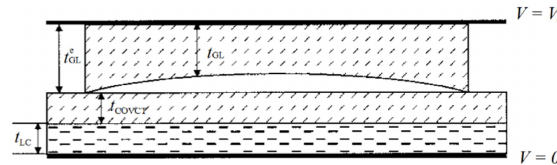
Figure 7. Multilayer liquid crystal lens [53]. Reprinted with permission from Wang, B.; Ye, M.; Sato, S. Applied Optics; published by OSA Publishing,